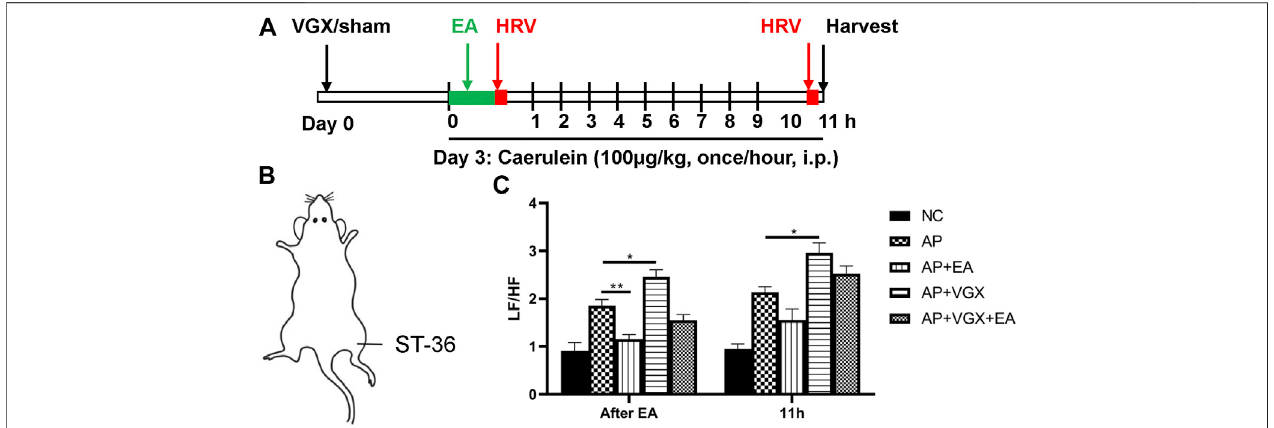
FIGURE 1 | Effects of EA on HRV in caerulein AP mice. (A) Schematic description of study design. Vagotomy/sham operation was performed three days before model induction.EAwasappliedimmediatelyafterthe fi rstcaerulein injection, andHRVwasobtained afterward.Miceweresacri fi ced2 hoursafterthelastcaerulein. (B) The location of ST-36 in mice. (C) The LF/HF of HRV after EA treatment and at 11 h later. n (cid:1) 7 – 10. Bars show mean ± SEM. * p < 0.05, ** p < 0.01. VGX, vagotomy; EA, electroacupuncture; HRV, heart rate variability; i.p., intraperitoneal injection; NC, normal control; AP, acute pancreatitis; LF/HF, low frequency/high frequency.